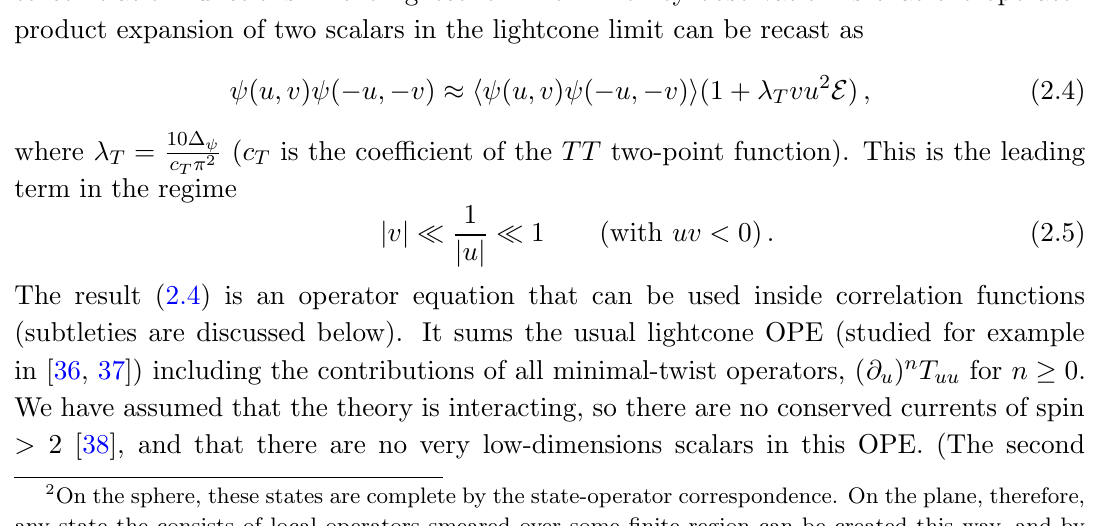
O duT uu O . h i R